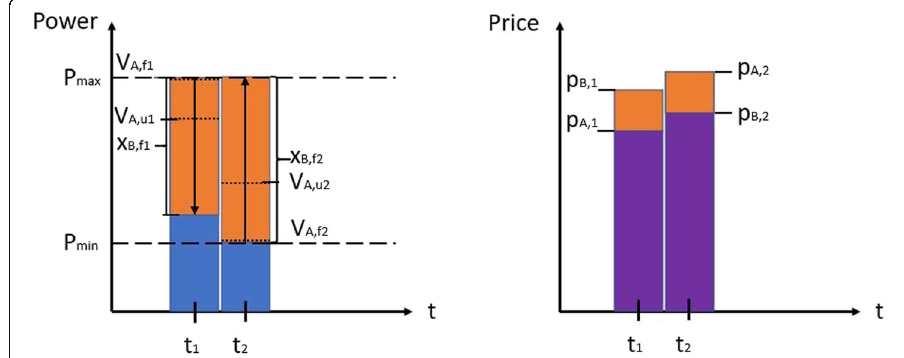
Fig. 3 Example of market arbitrage between submarkets A and